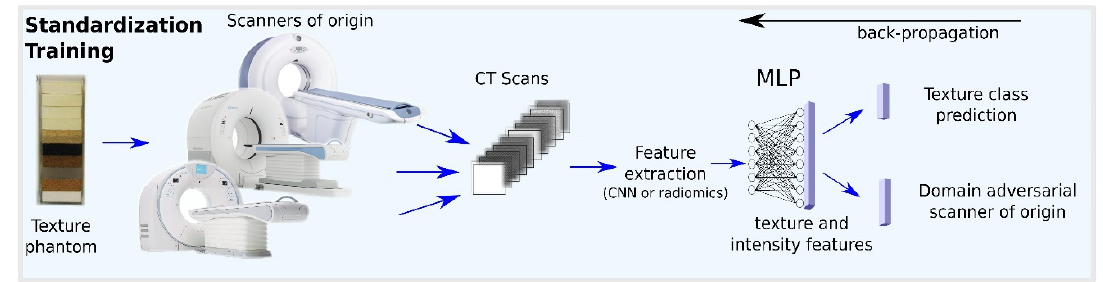
Figure 8. An overview of the proposed normalization method by [21] using a CT phantom. Figure adapted from [21]. Studies by Rozantsev et al. [181] and Sun and Saenko [182] have adapted divergence- based approaches for domain adaptation by using a two-stream CNN architecture (one in the source domain with synthetic images and the other in the target domain with real images) with unshared weights and the DeepCORAL [183] architecture, respectively. Their methodologies provided a domain-invariant representation by trying to reduce the